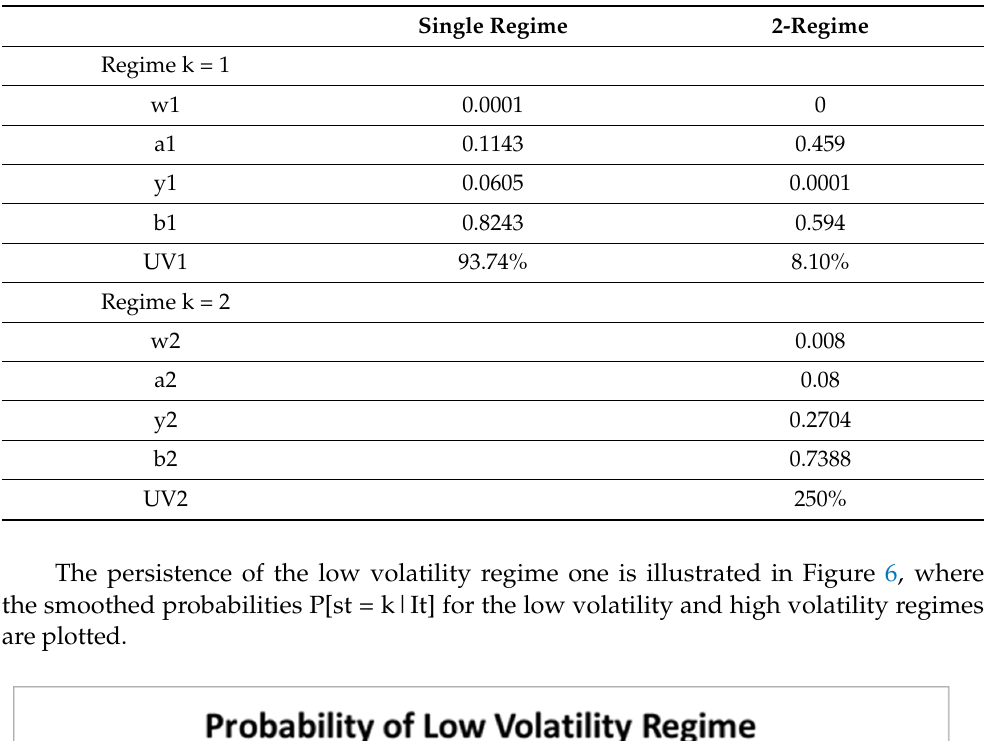
Table 9. Parameter Estimate.